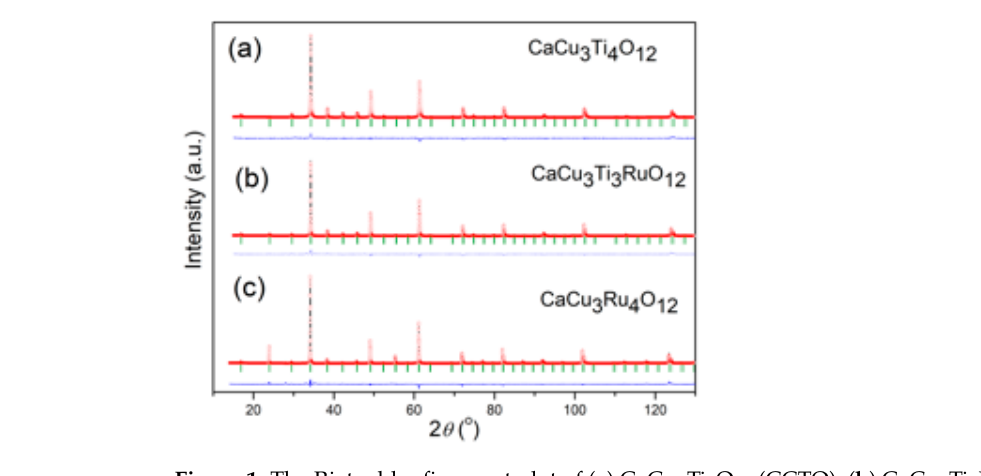
Figure 1. The Rietveld refinement plot of ( a ) CaCu 3 Ti 4 O 12 (CCTO), ( b ) CaCu 3 Ti 3 RuO 12 (CCT3RO), and ( c ) CaCu 3 Ru 4 O 12 (CCRO) samples. Table 1. The refined values of the fractional coordinates and isotropic displacement parameters of the CaCu 3 Ti 4 − x Ru x O 12 powders.